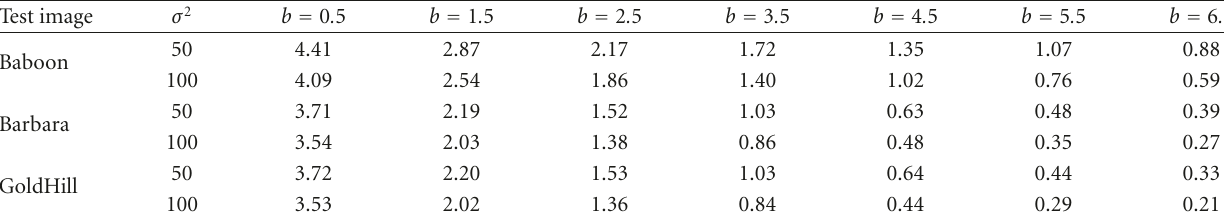
Table 1: Sets of the used bpp for the coder SPIHT for the considered test images and noise variances.